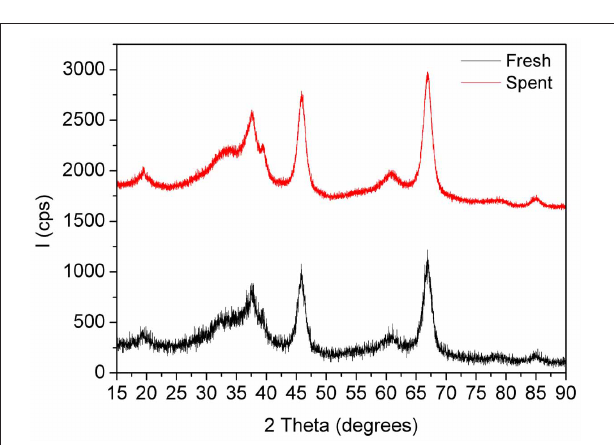
FIGURE 6 | XRD patterns of the fresh and spent Pd/ γ -Al 2 O 3 catalyst. Spent catalyst was collected from inside the plasma reactor.